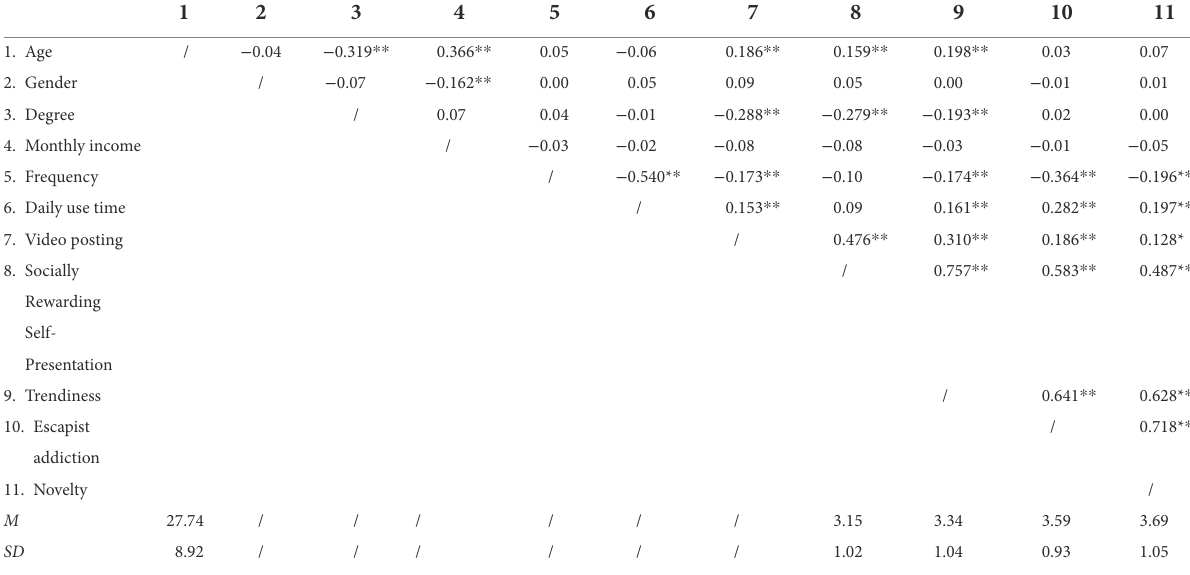
TABLE 2 Means, standard deviations for profile variables, and correlations among study variables.